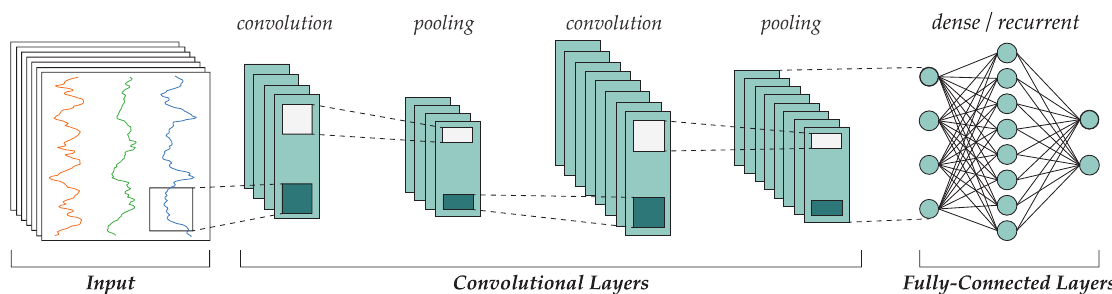
Figure 1. Common topology of a convolutional neural network.